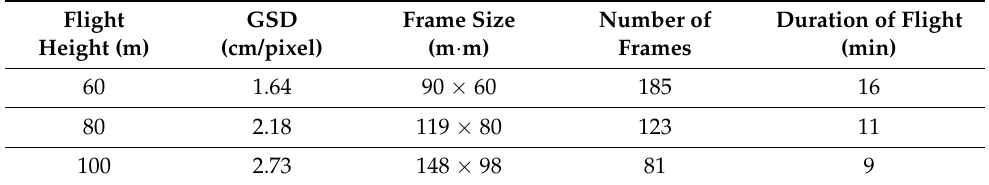
Table 3. Flight data, frame characteristics, frame number, and duration of flight.